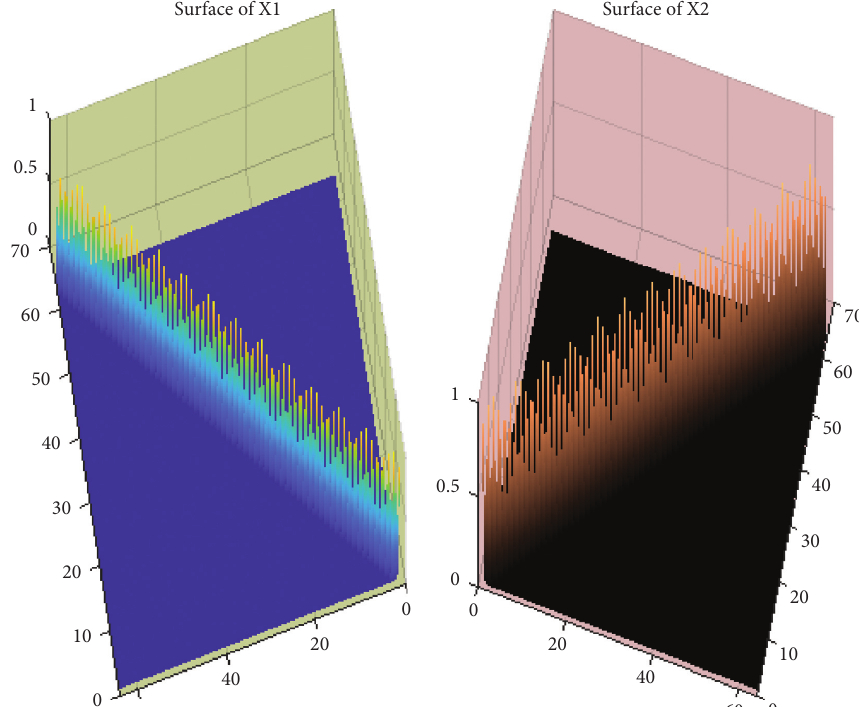
Figure 25: Solution surface plot for dimension